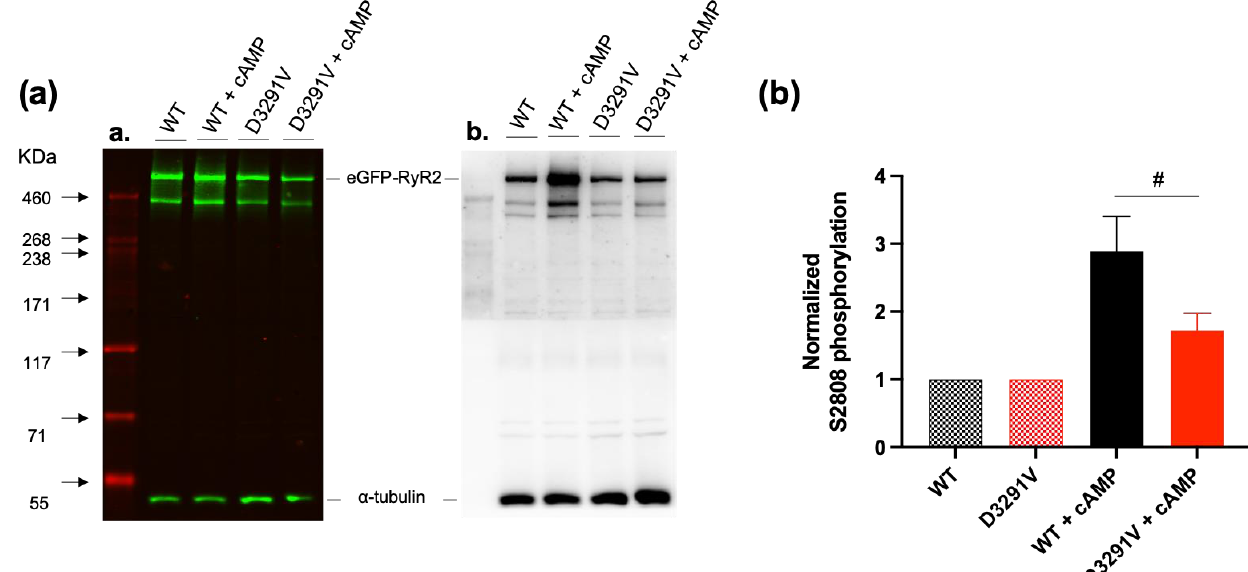
Figure 5. S2808 phosphorylation of both WT and D3291V in presence of cAMP: ( a ) Western blot of total proteins extracted from HEK293 cells transfected with eGFP-WT-hRyR2 or eGFP-D3291V-hRyR2 plasmids and treated or not with 250 µ M 8-Bromo-cyclic AMP (cAMP) (n = 6) revealed with anti-RyR2 (A.a.) or anti-pSer2808 (A.b.). ( b ) Quantification of Ser2808 phosphorylation normalized to RyR2 total expression. # p < 0.05, WT + cAMP compared to D3291V + cAMP.